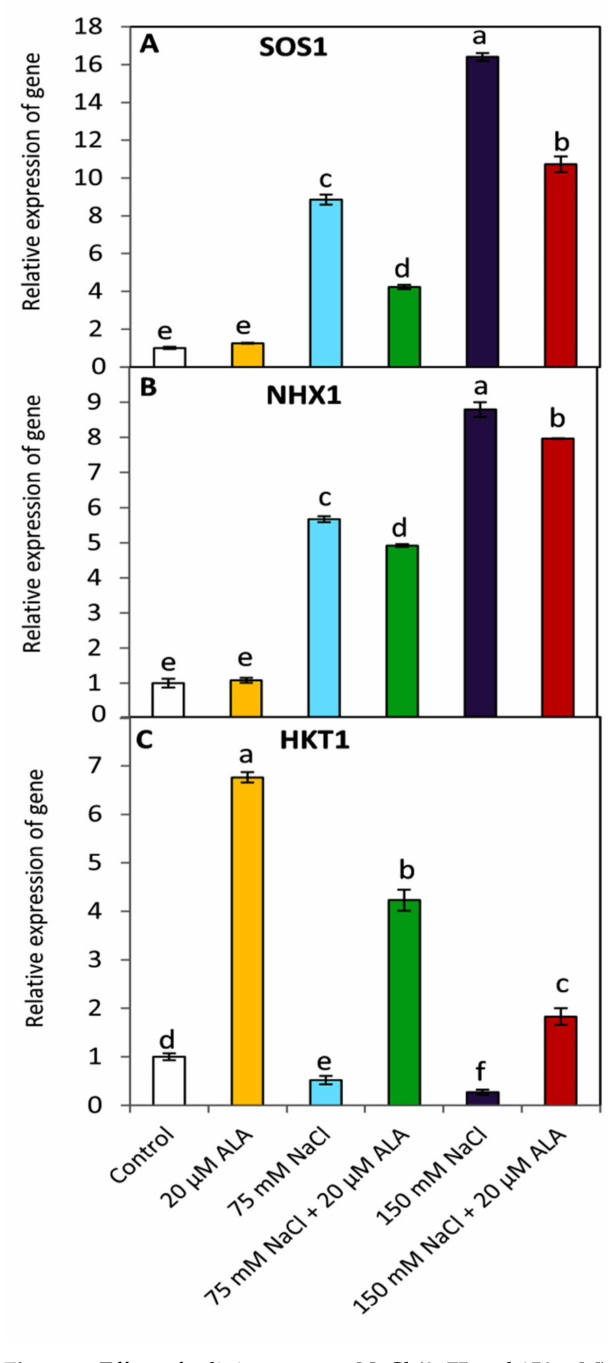
Figure 6. Effect of salinity stress as NaCl (0, 75 and 150 mM) and the foliar application by α -lipoic acid (ALA; 0 and 20 µ M) on the relative expression of SOS1 ( A ), NHX1 ( B ) and HKT1 ( C ) of sorghum plants. For each parameter, the mean values ± SD followed by a different letter are significantly ( p ≤ 0.05) different according to Tukey’s range